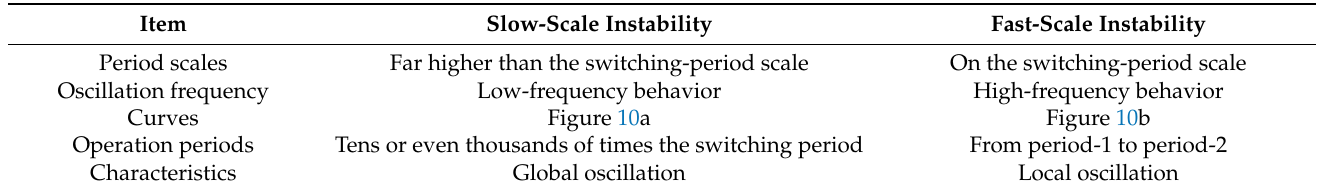
Table 7. Classification of complex dynamic behaviors.